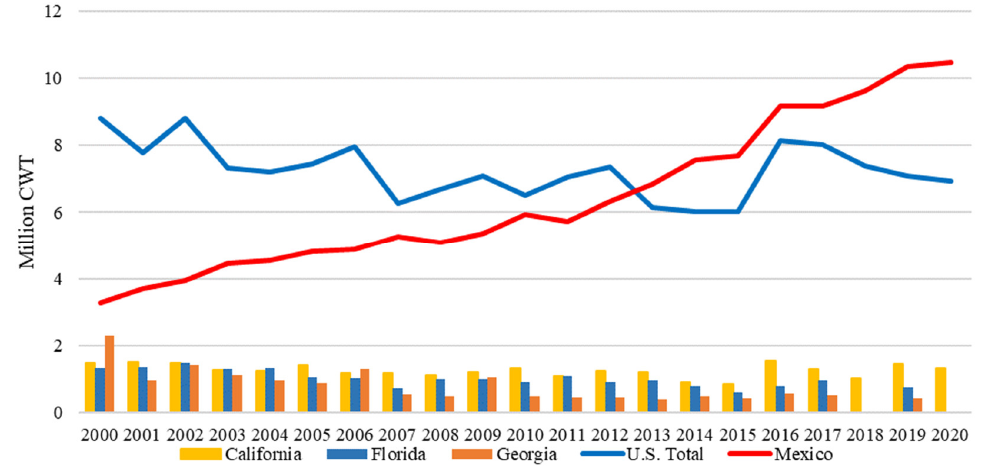
Figure 14. U.S. production and Mexican imports: squash. Notes: The data of Florida and Georgia in 2018 and 2020 are unavailable and not presented. Sources: USDA FAS [11]; USDA NASS